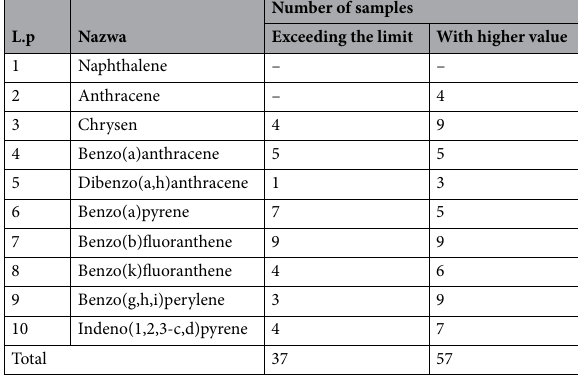
Table 5. Exceeding the standards and increased PAH results in the tested samples.